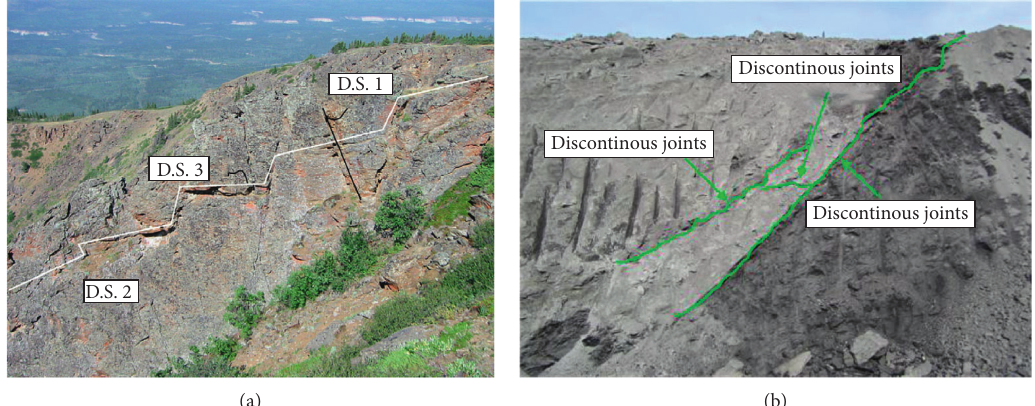
Figure 1: Photographs of typical examples of rock slope joints. (a) A joint at the top of a slope in Aishihik River bank. (b) A joint of a south slope of Xilinhaote open-pit mine.